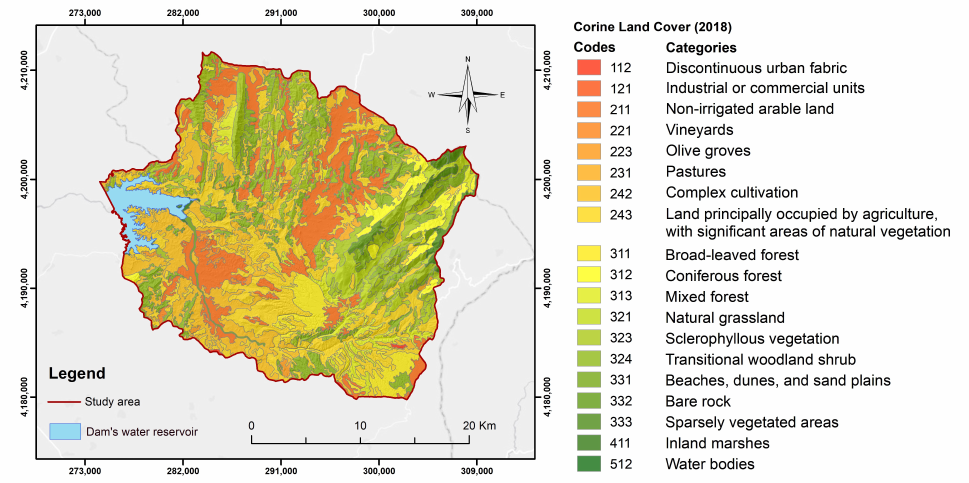
Figure 2. The land-use/land cover map based on Corine Land Cover (2018) for the research area. Subsequently, the land cover data of the 2018 version of the European Corine Land Cover (CLC) were obtained from the Copernicus Land Monitoring Services program [51] for the calculation of the cover management factor (C) of the RUSLE